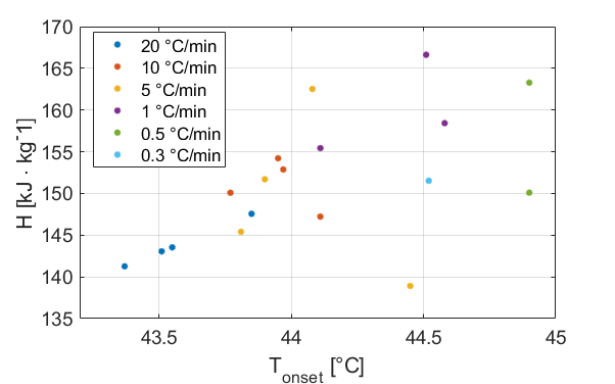
Figure 13. Dispersion of energy storage data for RT45 paraffin in the cooling